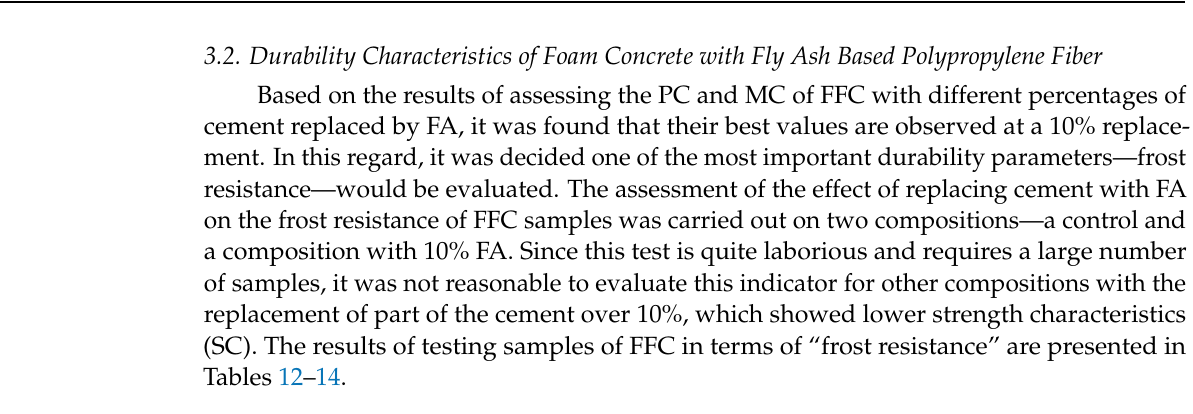
Table 12. Results of determining the CS of control samples.